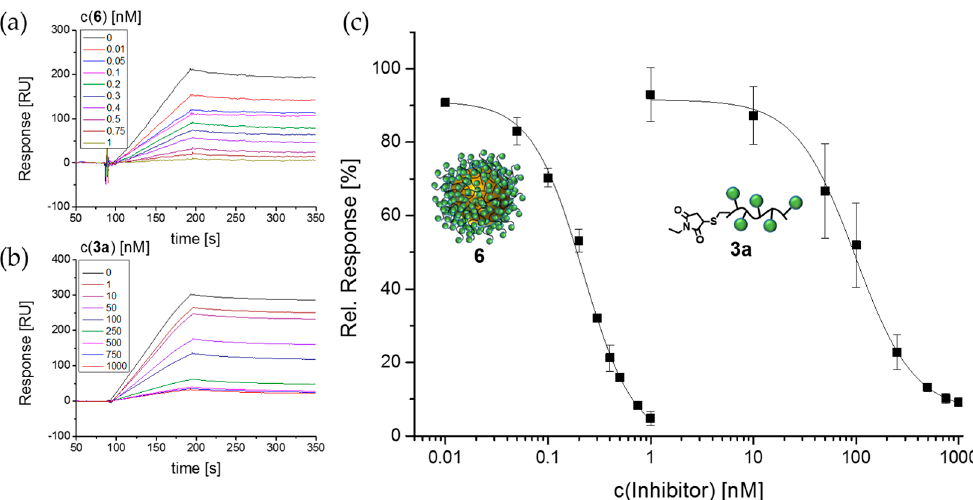
Figure 5. Exemplary SPR sensorgram for solutions of 100 nM Con A incubated with serial dilutions of ( a ) glyco-AuNP 6 and ( b ) N -methylmaleimide capped glycomacromolecule 3a ; ( c ) resulting IC 50 curve fitted to Hill1 function for glyco-AuNP 6 and N -methylmaleimide capped glycomacromolecule 3a . Table 4. IC 50 and RIP values as measured for glyco-AuNPs 4 – 6 and N -ethylmaleimide capped glycomacromolecules 1a and 3a by SPR and derived RIP values corrected for glycomacromolecule and carbohydrate number per